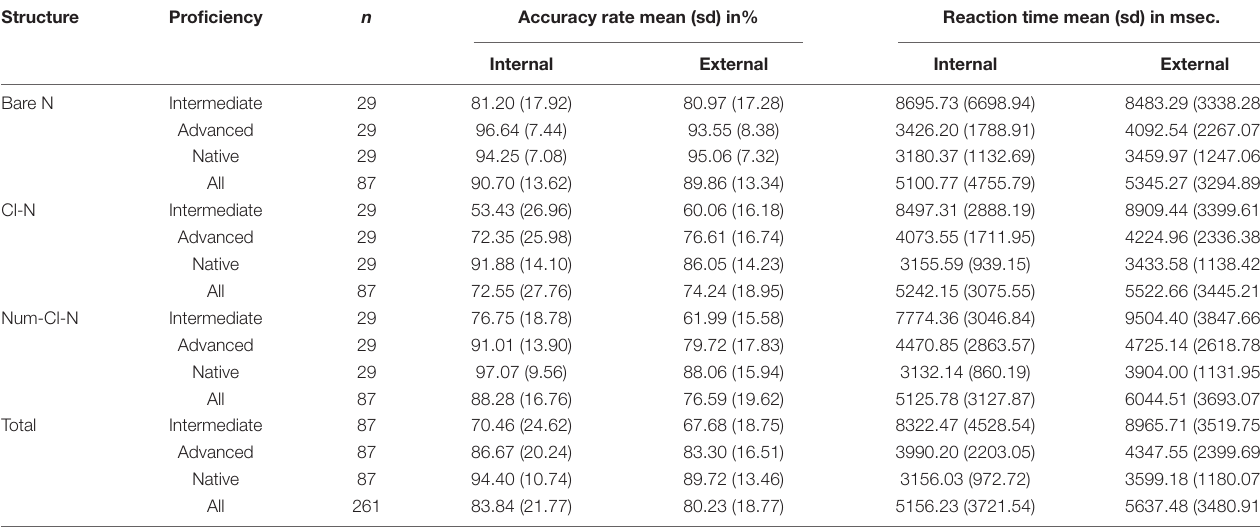
TABLE 2 | Descriptive statistics of accuracy rate and reaction time by group, interface and syntactic structure.